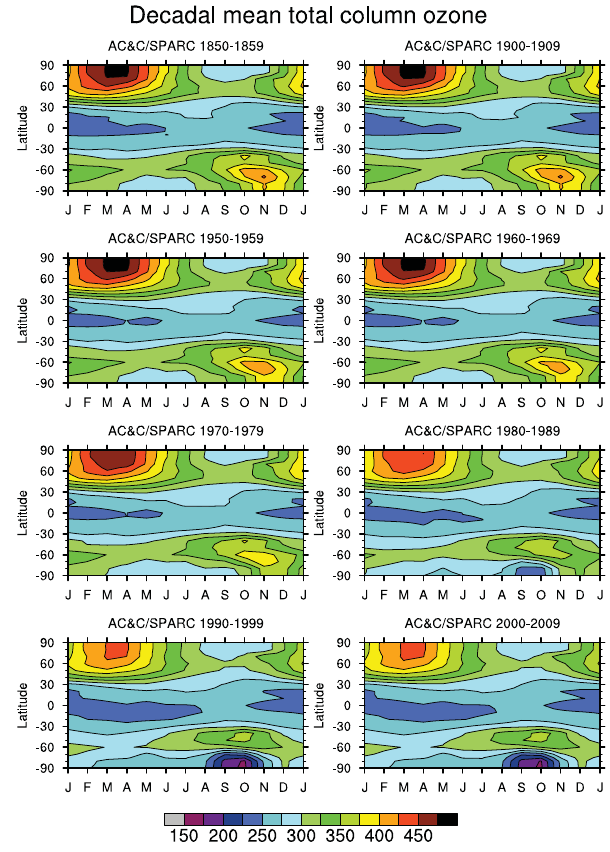
Fig. 4. Decadal mean total column ozone [DU] in the historical part of the ozone database. The decades span the period from the 1850s (top left) to the 2000s (bottom